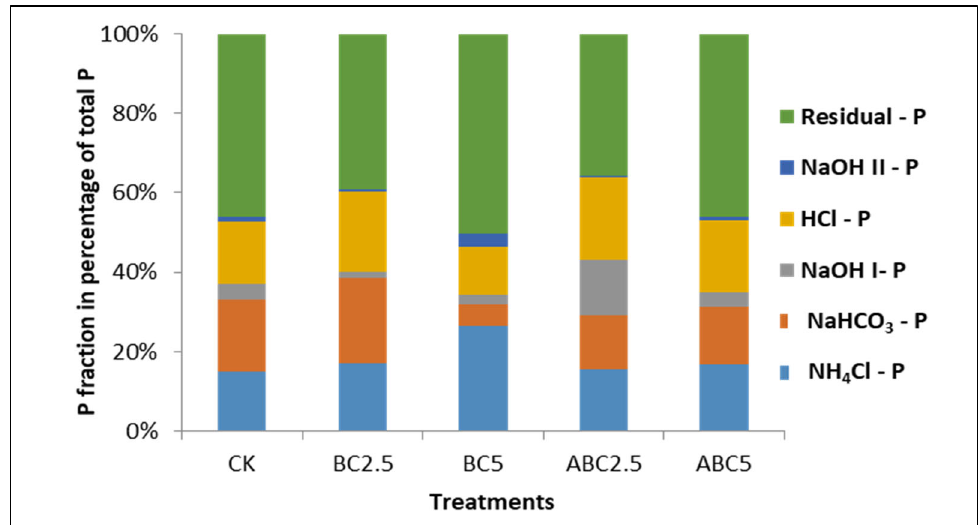
Figure 15. Effect of BC and ABC applied at different rates on P fractionation on soil treated with 75 ppm P. CK = Control, BC2.5 = Biochar added at 2.5% w / w , BC5 = Biochar added at 5% w / w , ABC2.5 = Acidified biochar added at 2.5% w / w , and ABC5 = Acidified biochar added at 5% w / w .